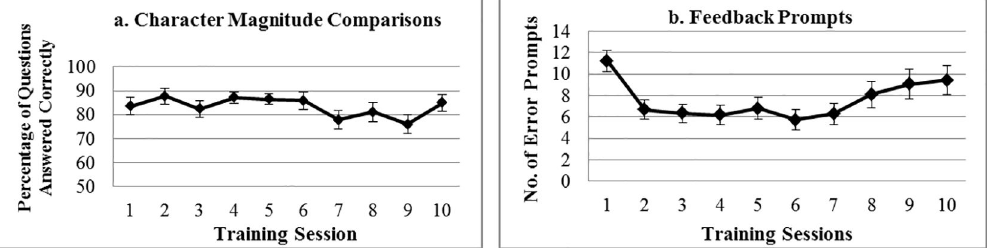
Figure 3. Training performance while playing the numerical magnitude game: a) the percentage of the magnitude comparison questions answered correctly (i.e., Who is leading?), b) the number of times feedback was given in response to an